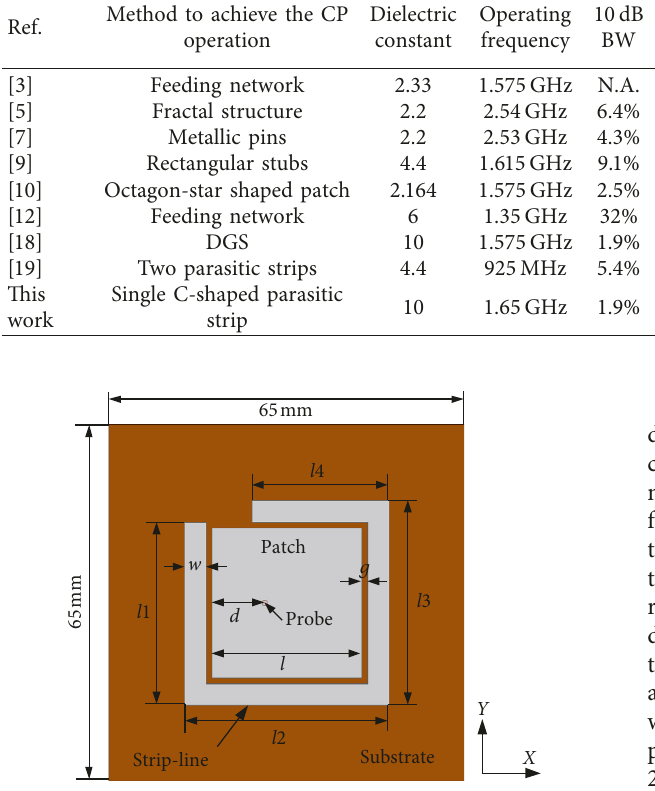
Table 1: Comparison of this work and previous published CP antennas. Ref.